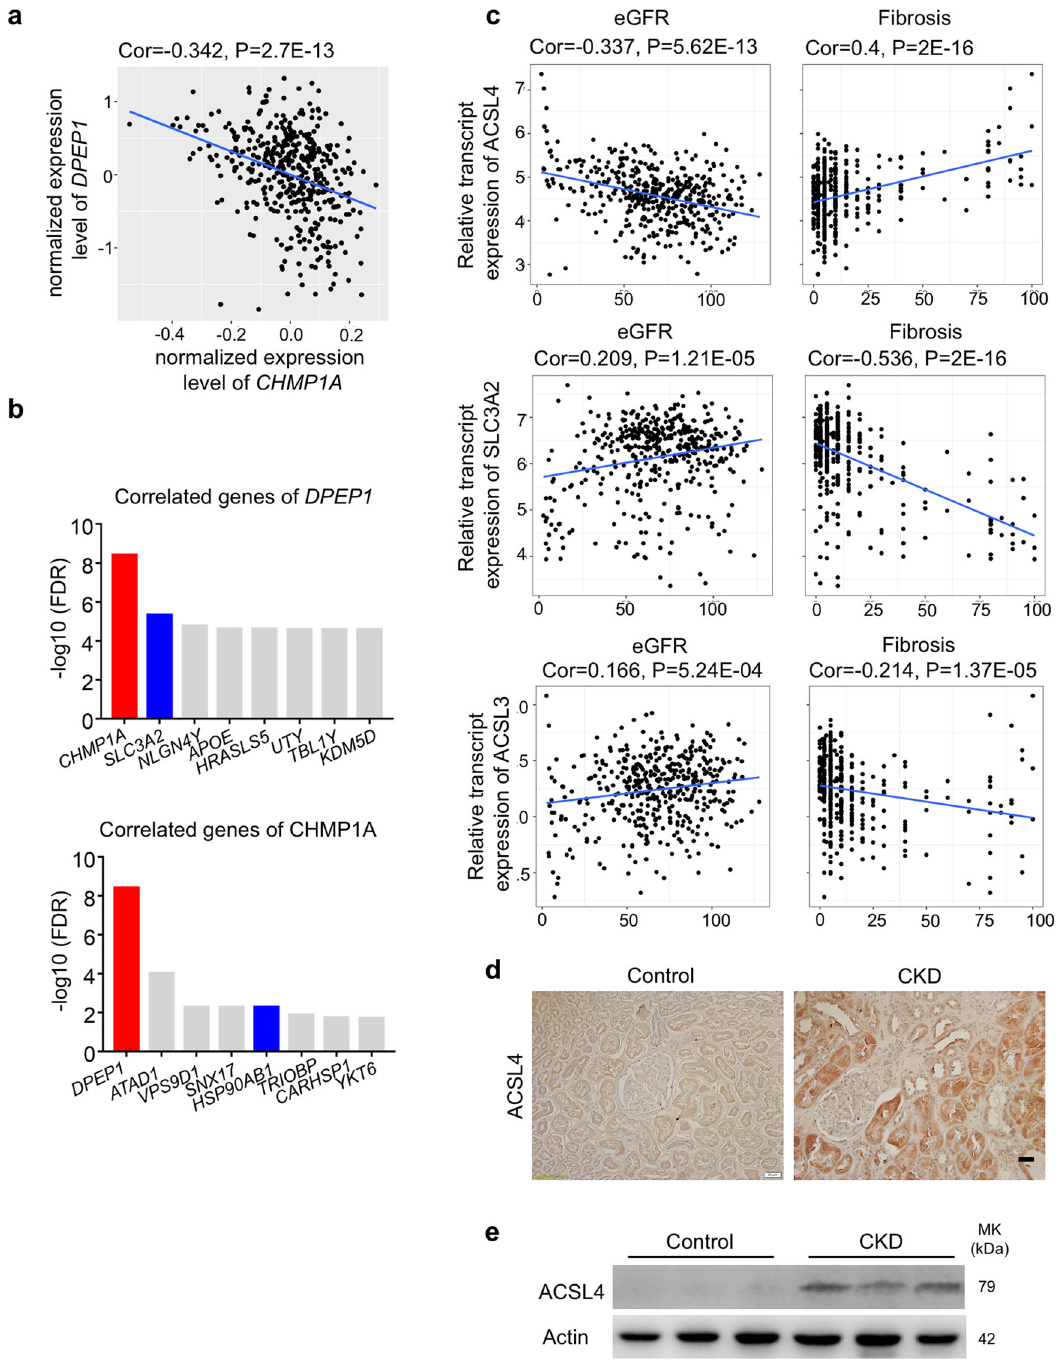
Fig. 8 DPEP1 and CHMP1A levels correlate and associated with ferroptosis gene expression in human kidney samples. a Relative expression of DPEP1 (y-axis) and CHMP1A (x-axis) in 432 microdissected human kidney tubule samples. Pearson correlation is shown. Student t -test based on the Pearson correlation coef fi cient was used to calculate the statistical signi fi cance of the association. b Genes showing signi fi cant correlation with DPEP1 and CHMP1A in microdissected human kidney tubule samples. y - axis represents the Pearson correlation P value. c Relative transcript levels of ACSL4 , ACSL3 , and SLC3A2 (FPKM, y-axis), and kidney function (eGFR, x-axis) or kidney fi brosis (x-axis) as analyzed in 432 microdissected human kidney samples. Pearson correlation is shown. Student ’ s t -test based on the Pearson correlation coef fi cient was used to calculate the statistical signi fi cance of the association. d Representative images of ACSL4 immunostaining in healthy control and CKD kidney samples. Scale bar: 20 μ m. e Western blots of ACSL4 in healthy control and CKD kidney